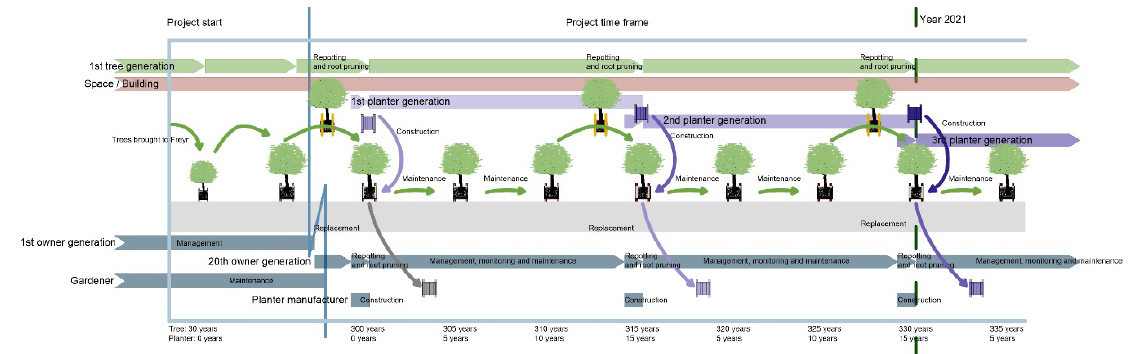
Figure 14. Time diagram of “Orangery Castle Freyr”.